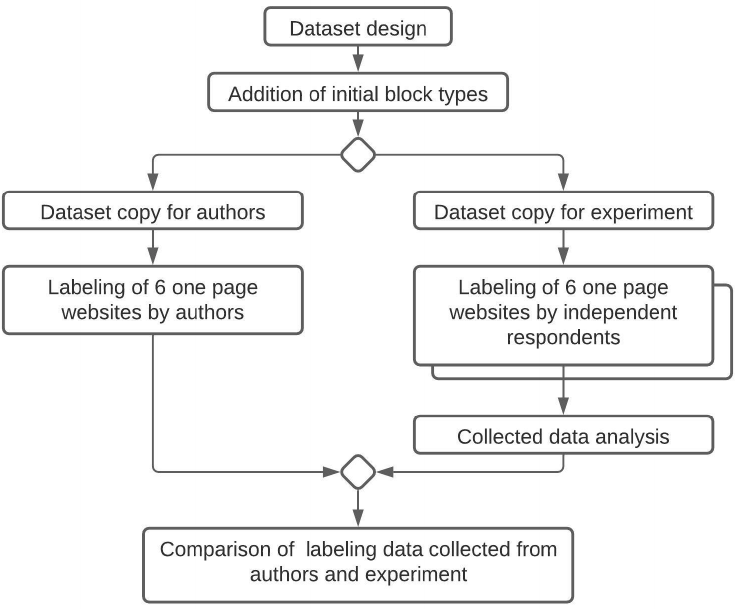
Figure 4. Basic schema of the experiment for the dataset schema validation.